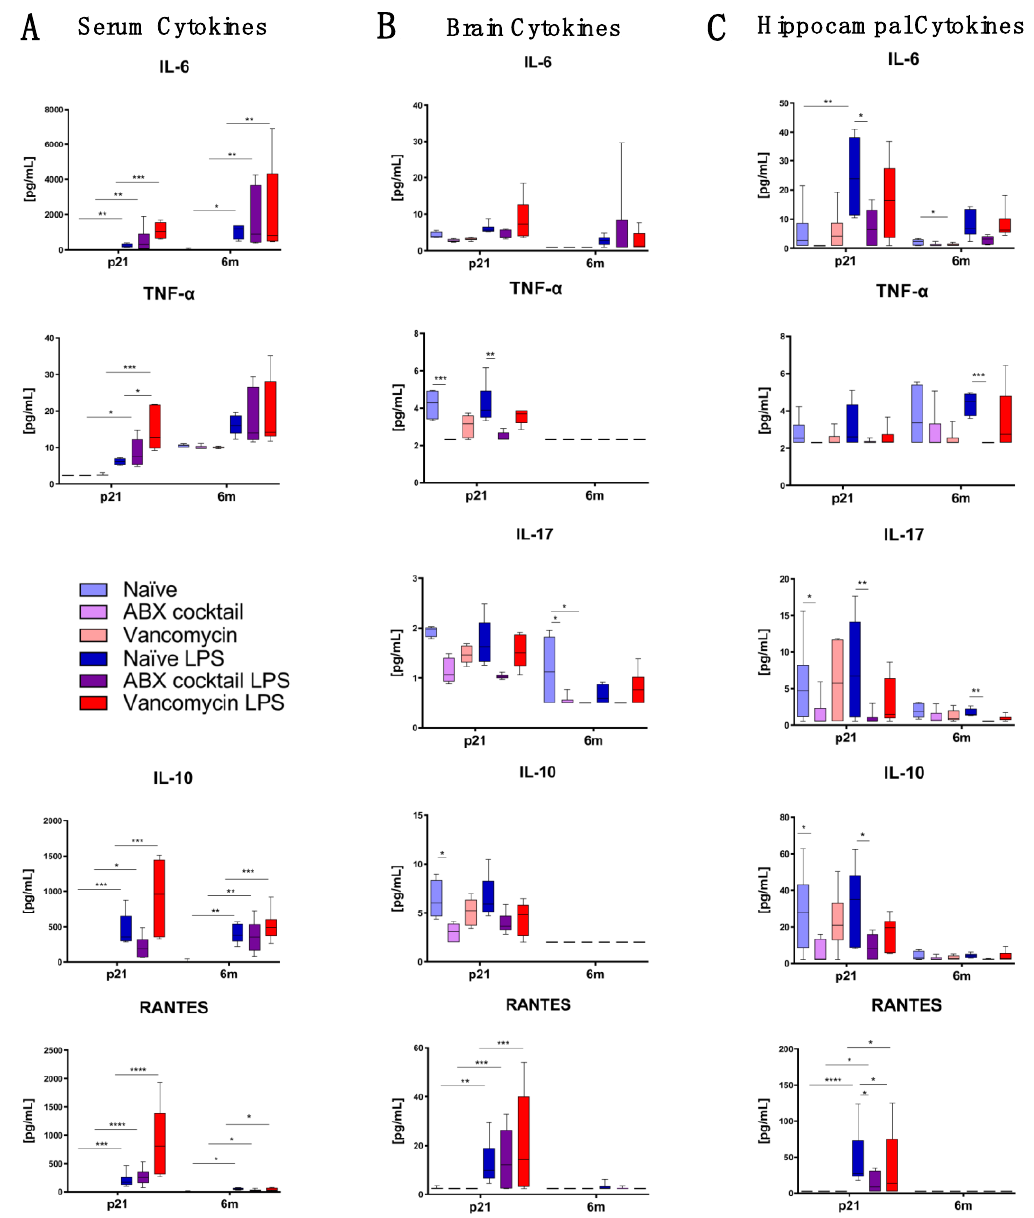
Figure 4. Inducible cytokines are affected by ABX exposure. Luminex data showing the responses of IL-6, TNF α , IL-17, IL-10, and RANTES from ( A ) serum ( B ) brain and ( C ) hippocampus. Each color represents a unique prenatal basal exposure with or without LPS stimulation: naive = light blue, vancomycin = light red, ABX-cocktail = light purple, naive LPS = blue, vancomycin LPS = red, and ABX-cocktail LPS = purple. Naive, vancomycin, and ABX-cocktail samples were run in parallel. The levels of significance ( p -values) determined by Kruskal–Wallis with Dunn’s multiple comparison test. Values represent median (min-max), * p ≤ 0.05, ** p ≤ 0.01, *** p ≤ 0.001, and **** p ≤ 0.0001.